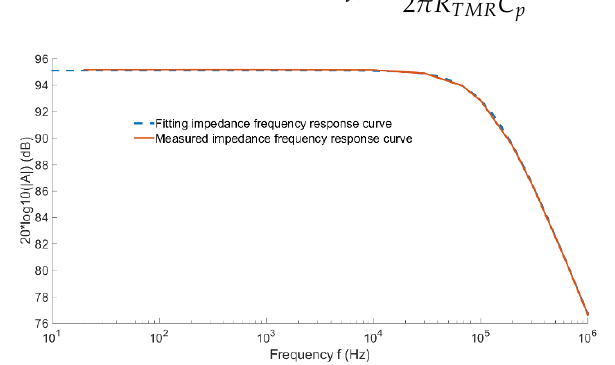
Figure 10. TMR2003 impedance frequency response curve.